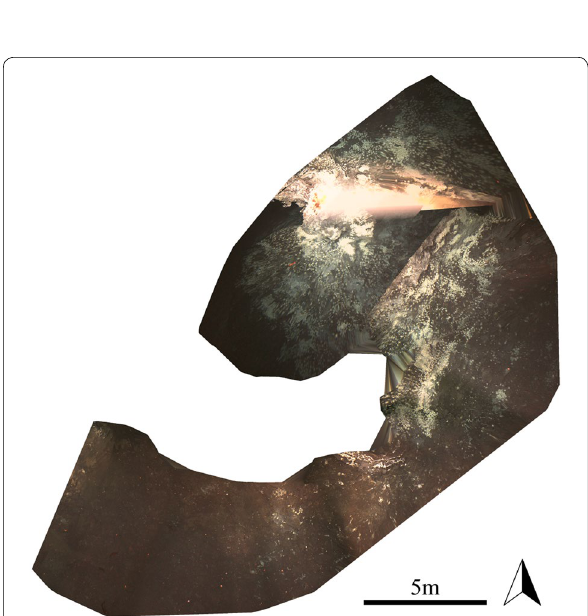
Fig. 11 Top view of 3D colour reconstruction of the NBC